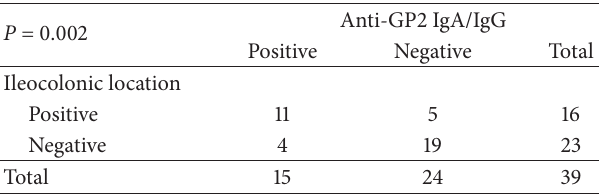
Table 1: Association of anti-GP2 IgA and/or IgG with location of disease in CD.